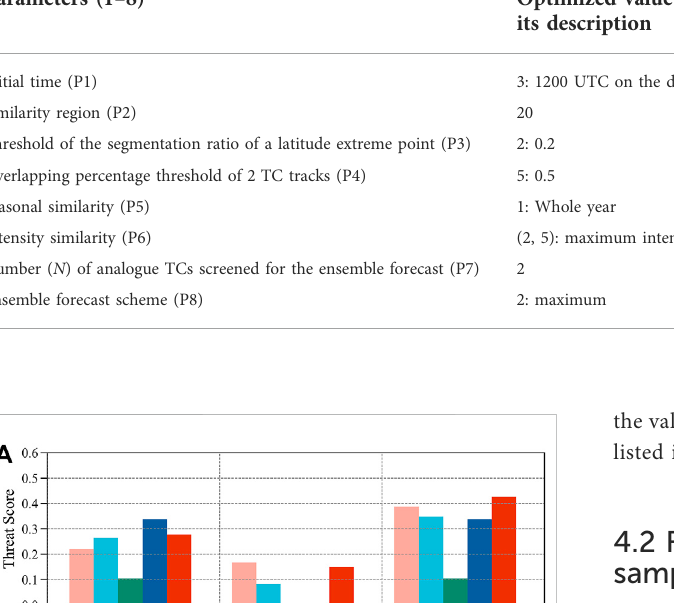
FIGURE 7 Comparisonoftheaverageforecastskillscores(i.e., (A) TS, (B) FAR, (C) MR and (D) BS) of different models (CMA, ECMWF, JMA, NCEP, and the best forecast scheme of the DSAEF_LTG model) at thresholds above BeaufortScale 7and 10.Notethat all theBS values were reduced by 1 for better comparisons, and the sum of average BS was de fi ned as ± (|BS7|+|BS10|), where the symbol depended on